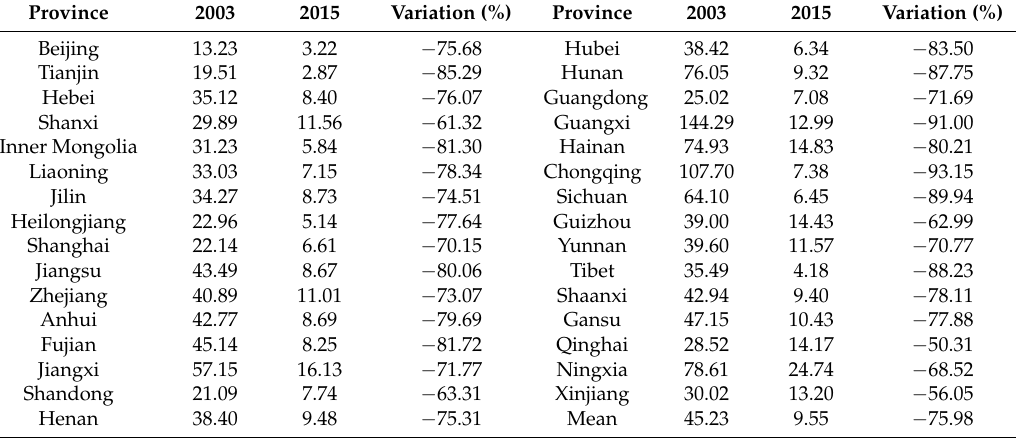
Table 2. Regional distribution of changes in IWEI from 2003 to 2015. Unit: (Mt/10,000 RMB).